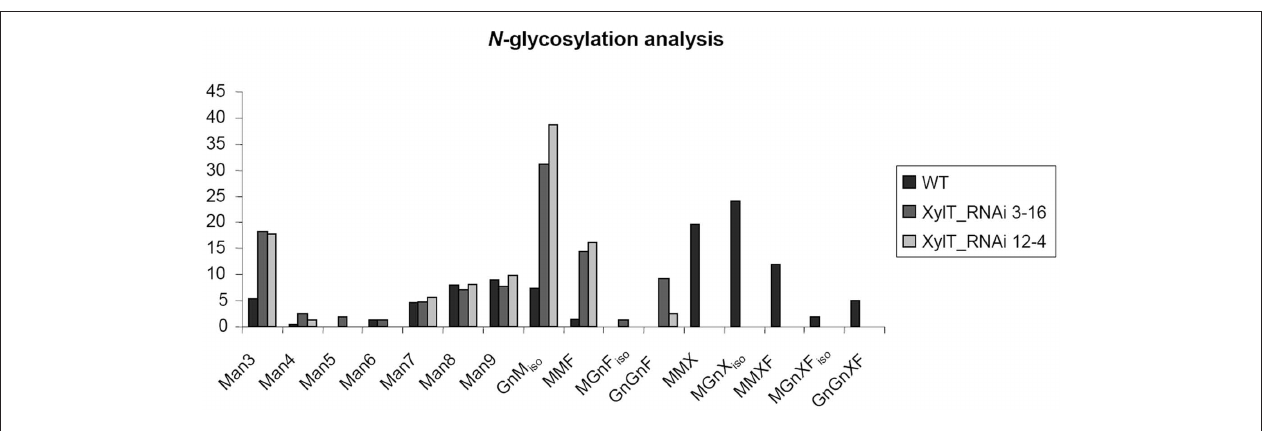
FiguRe 5 | N -glycosylation analysis of tomato proteins by mass spectrometry. The area percentages were calculated from the peak areas within the mass spectra. Absolute SDs are typically in the range of 1–3% with larger values for larger peaks and vice versa. Glycans carrying a xylose residue